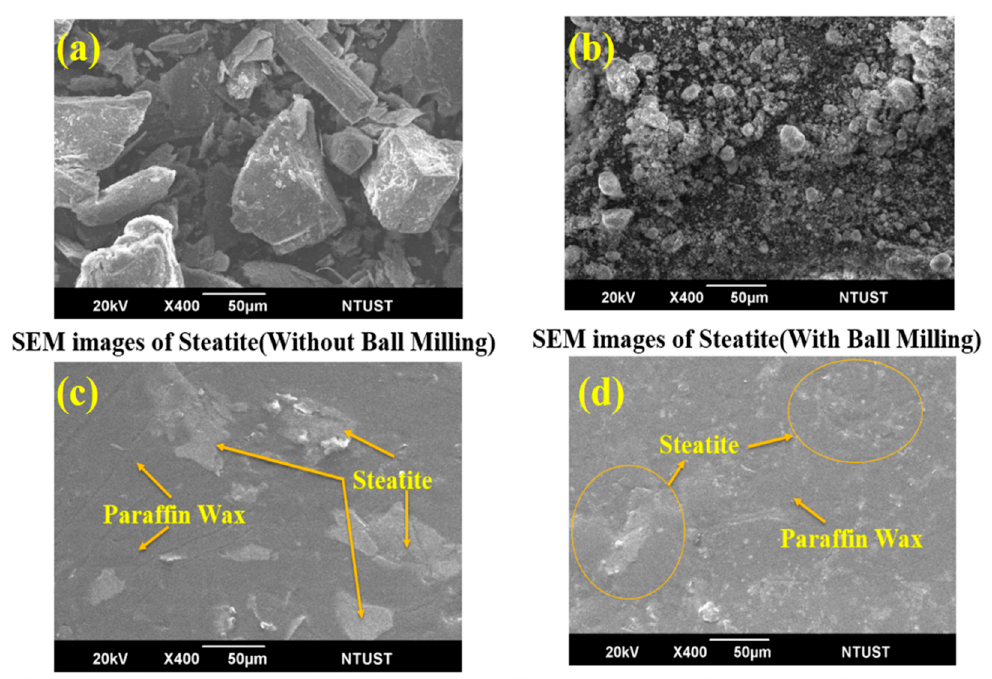
Figure 3 . Particle size measurement .